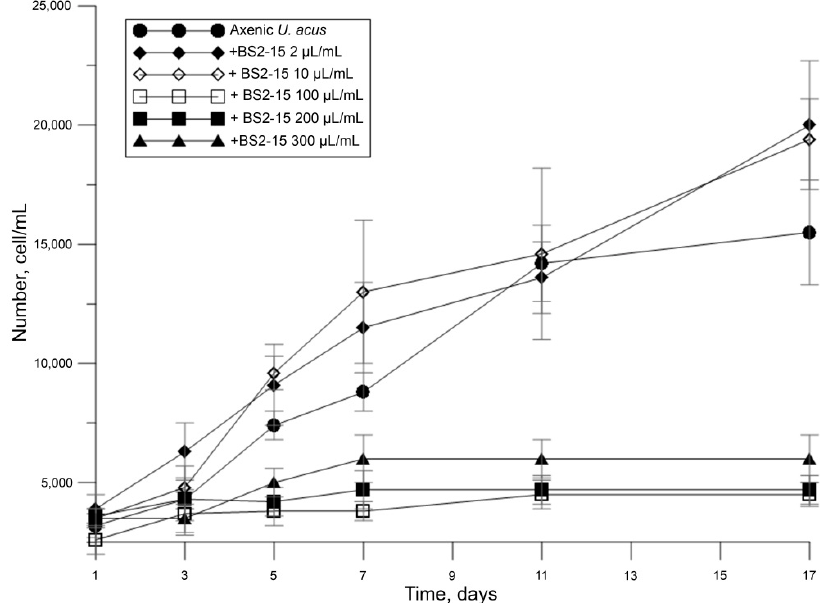
Figure 3. Inhibition of U. acus BK280 growth after inoculation with different concentrations of B. mycoides BS2-15 bacterial culture (microliters from optical density of bacterial culture of 0.9–1.0 at A600 nm).